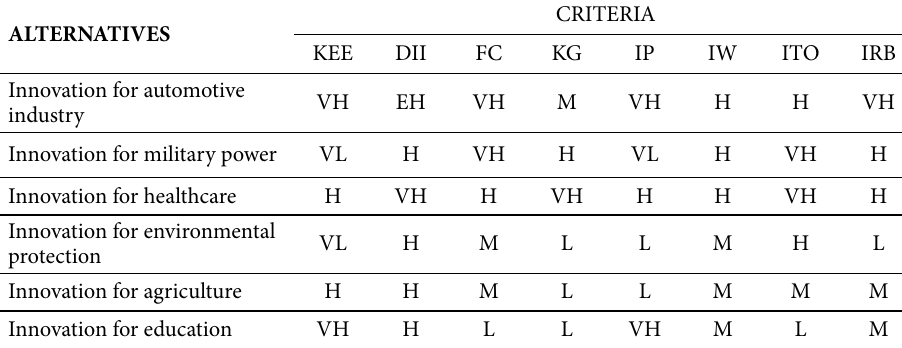
Table 2. Decision matrix with linguistic evaluations